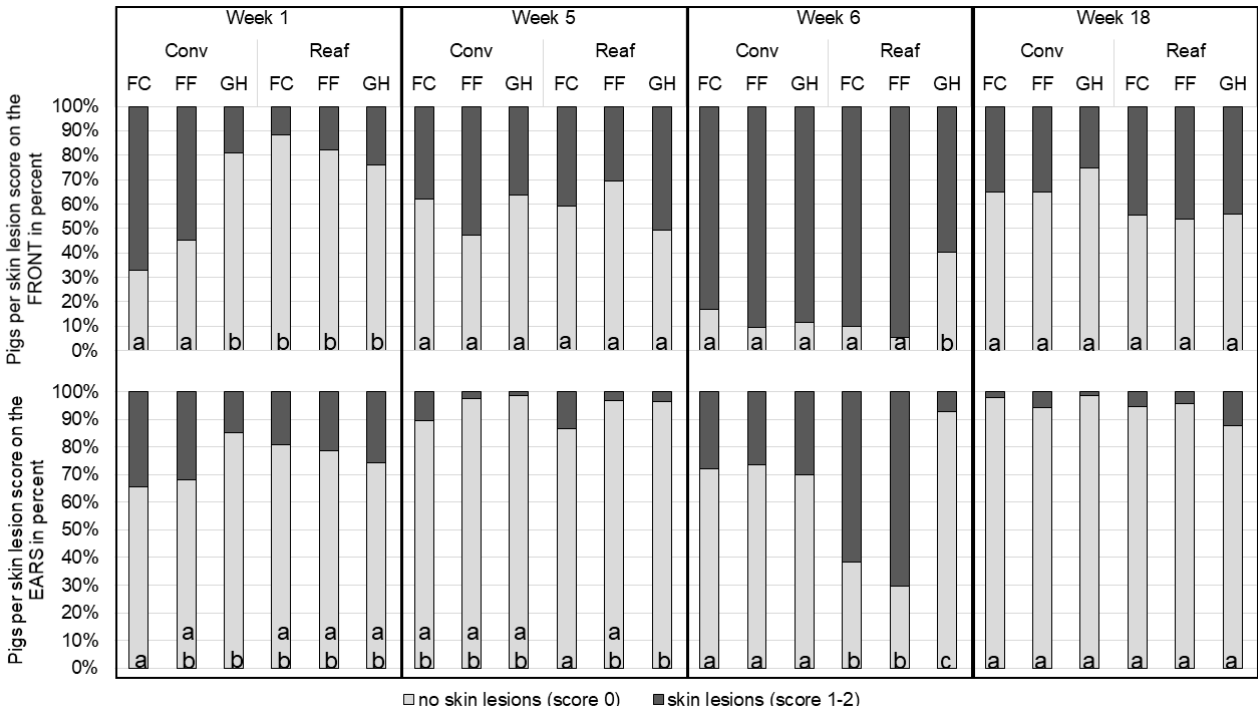
Figure 3. Estimated frequencies of skin lesions in percentages for the interaction rearing system × farrowing system × assessment week per body part (Conv: conventional rearing; Reaf: rearing in the farrowing pen; FC: farrowing crate; FF: free farrowing pen; GH: group housing of lactating sows; a–c: different letters indicate significant differences of score 0 (no lesions) within week and body part ( p < 0.05)).